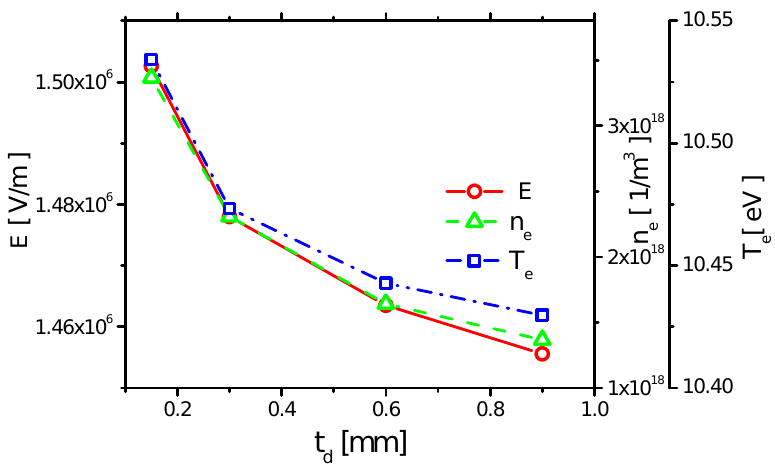
(cid:12) (cid:12) (cid:42) (cid:12) (cid:12) E (cid:12) (cid:12) , electron density n e , and electron